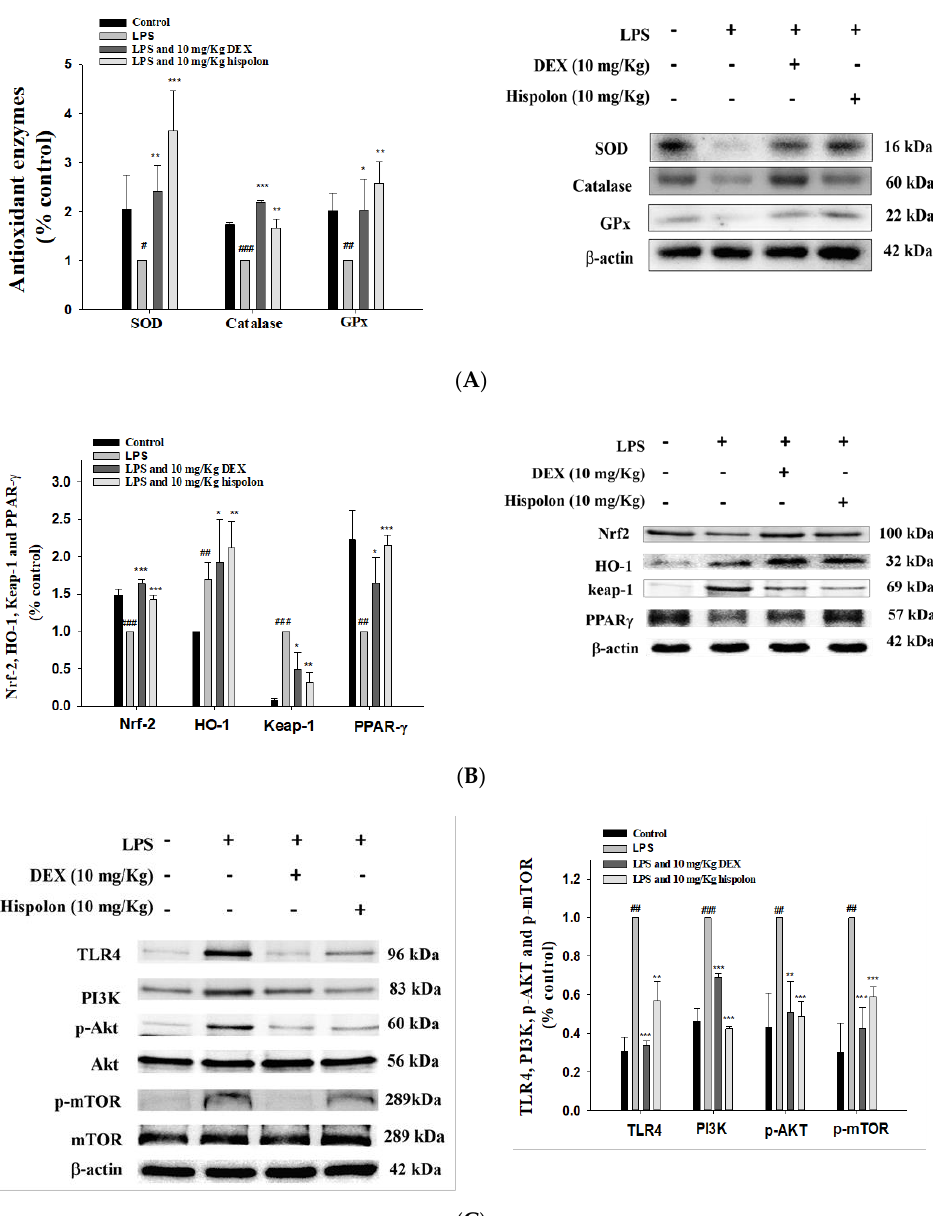
Figure 5. Effects of hispolon on ( A ) LPS challenge catalase, superoxide dismutase (SOD) and GPx; ( B ) HO-1, Nrf2, Keap1 and PPAR γ; ( C ) and TLR4, PI3K, Akt and mTOR protein expression in the lungs. Lung tissue extracts were subjected to Western blot analysis using antibodies for catalase, SOD, GPx, HO-1, Nrf2, Keap1, PPAR γ, TLR4, PI3K, Akt and mTOR. Data are represented as means ± S.E.M. (n = 3). ## p < 0.01 and ### p < 0.001 versus the control group. * p < 0.05, ** p < 0.01 and *** p < 0.001 versus the LPS group.